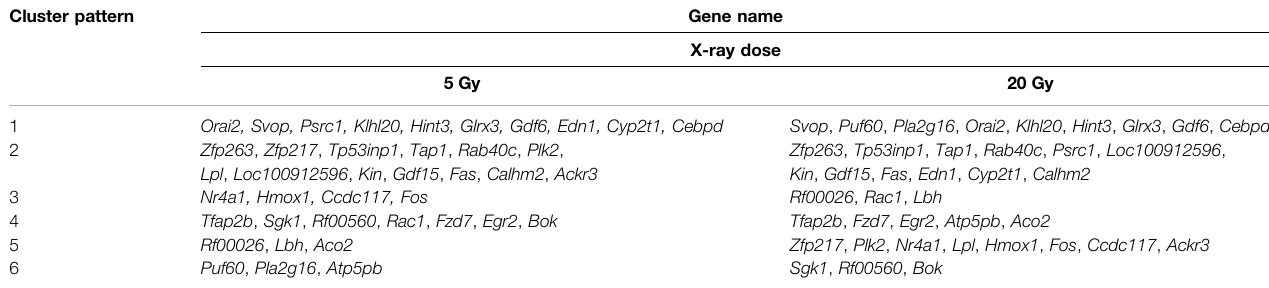
TABLE 2 | Differentially expressed gene level patterns over time in brain microvascular endothelial cells, by x-ray exposure dose. Cluster